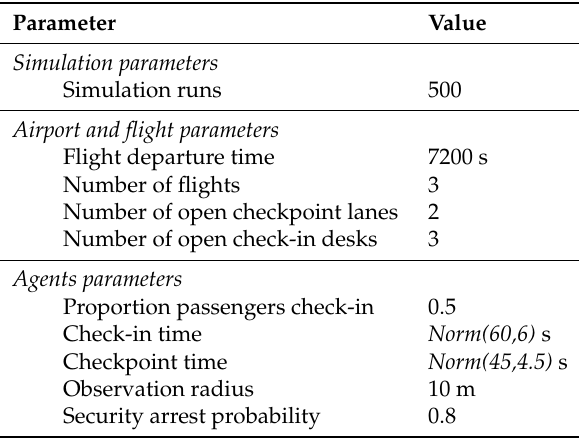
Table 2. Agent-based model